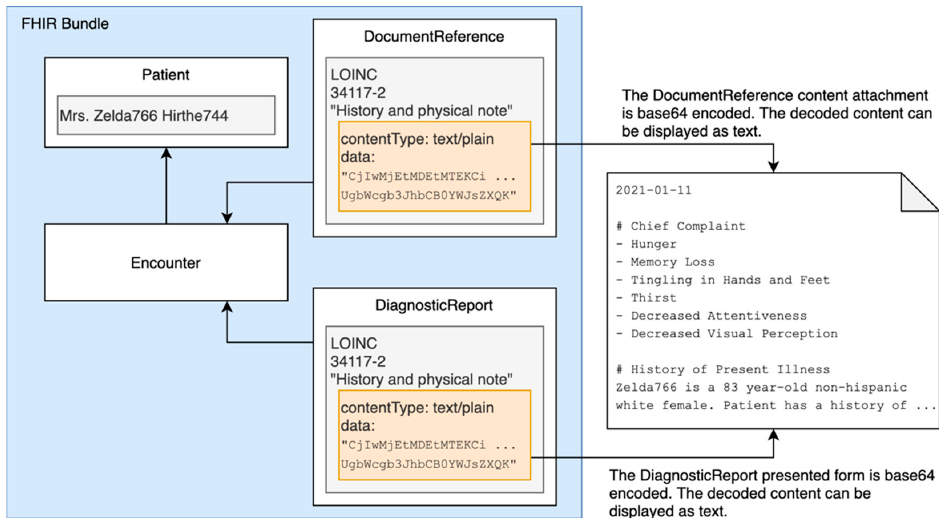
Figure 4. Relationship of FHIR Resources to clinical notes generated during an encounter for a synthetic patient. Rather than external files containing the notes, the notes themselves are Base64 encoded and included within the relevant FHIR resources, as per the FHIR specification.